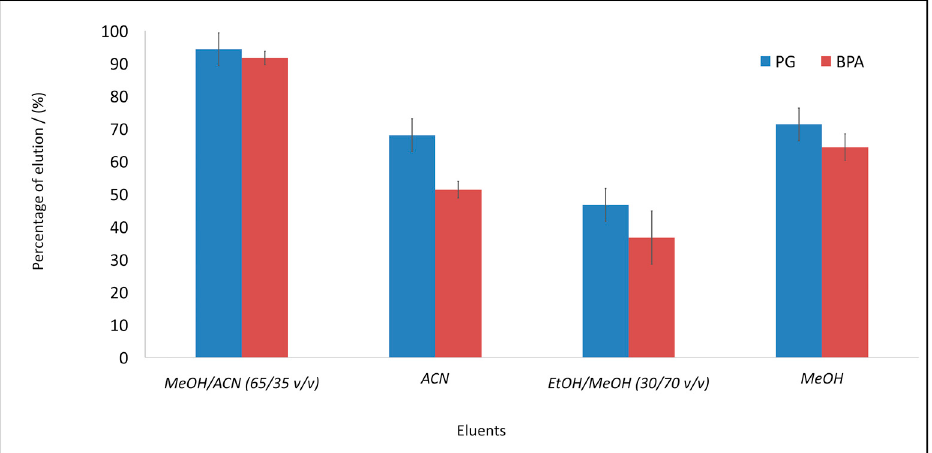
Figure 7. Elution of PG and BPA from MIP 2, with four different solvents. Error bars represent ±1 standard deviation. Experiments were performed in triplicate.